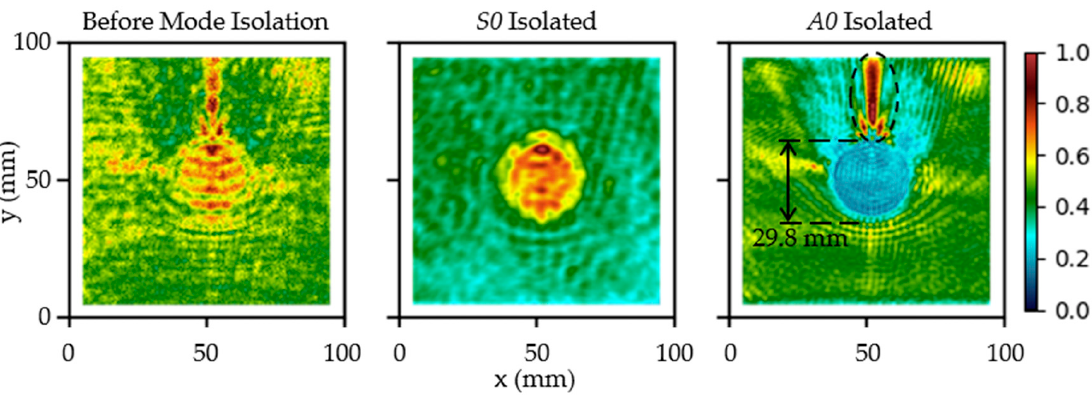
Figure 10. Spectral energy maps of Case D2, processed from un fi ltered ( left ), S0 -isolated ( middle ), and A0 -isolated data ( right ). The dramatic improvement in visualization clarity can be seen after applying the mode fi lter.